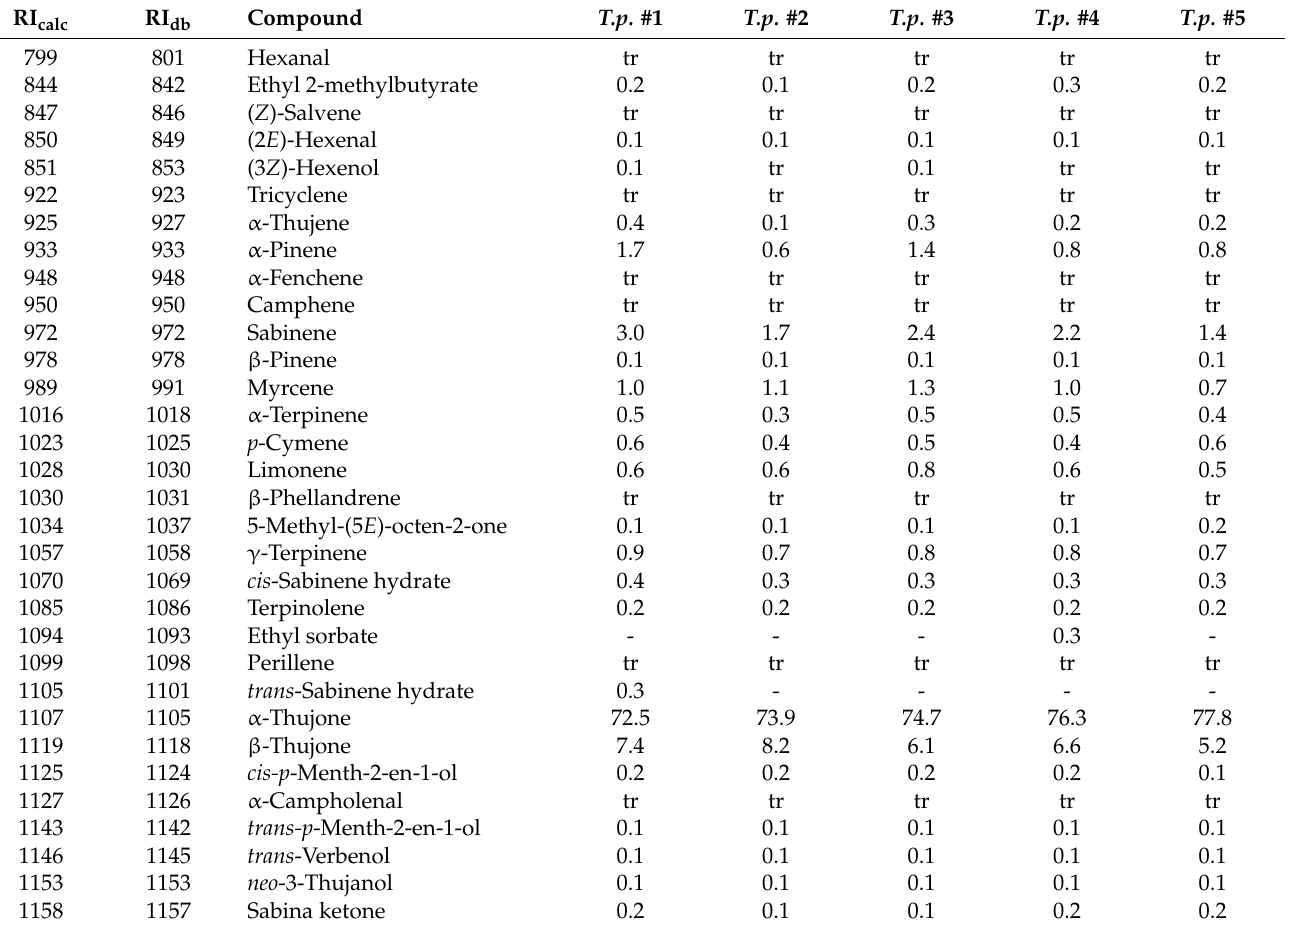
Table 5. Chemical composition (percent) of the foliar essential oils of Thuja plicata from northern Idaho. RI